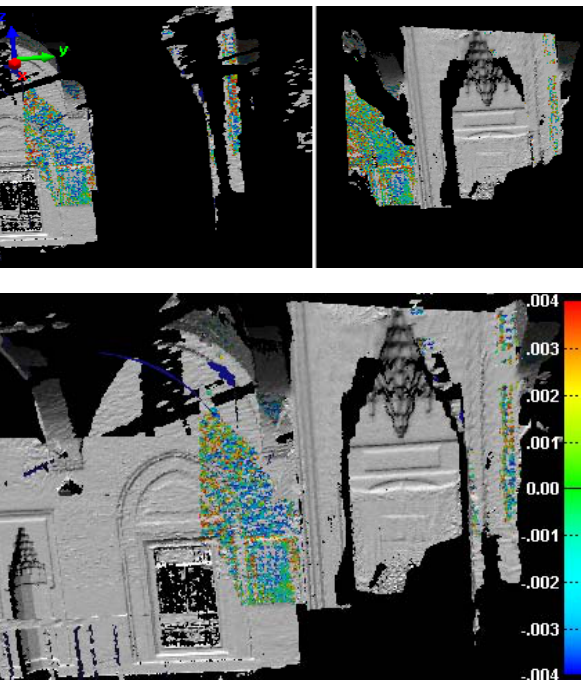
Figure 4. The TLS point cloud is reference. The IB3D point cloud of the first study was registered into reference system with ICP. The scale bar shows low divergences. [m]